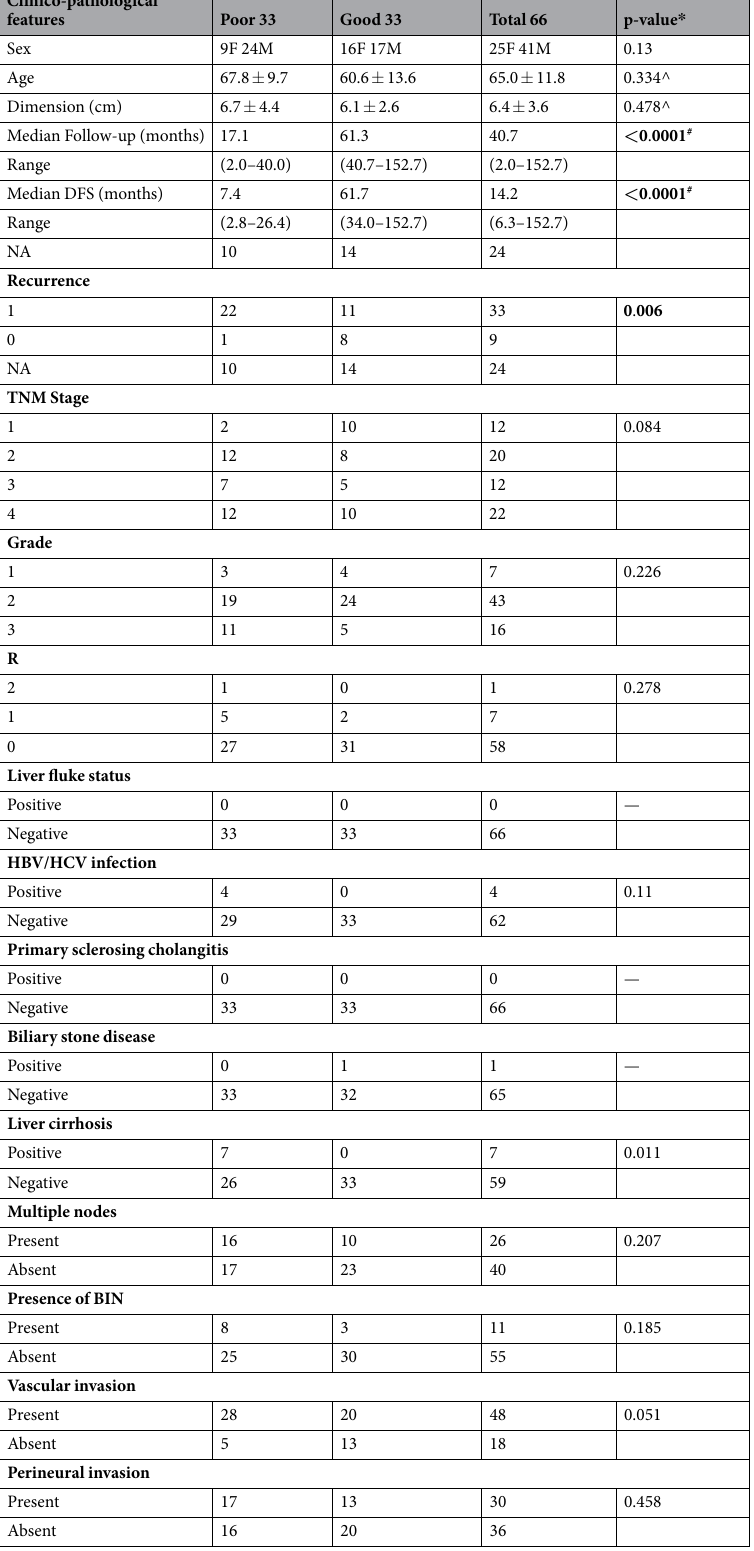
Table 1. Clinico-pathological features of 66 intrahepatic cholangiocarcinomas included in the study. Note: BIN, biliary intraepithelial neoplasia; DFS, disease free survival; NA, not available; R, resection margins. *